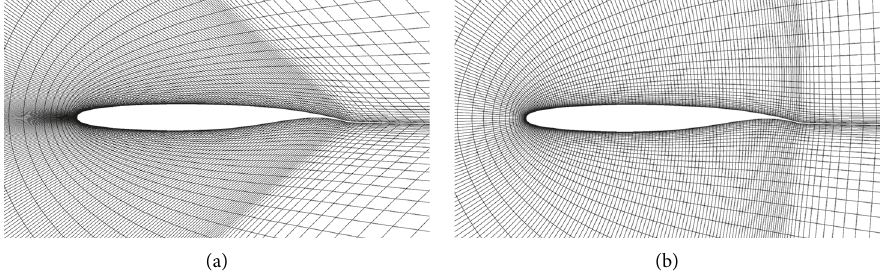
Figure 8: Closeup of Euler meshes optimized without curvature functions. (a) Optimized without orthogonality functions. (b) Optimized with orthogonality functions.